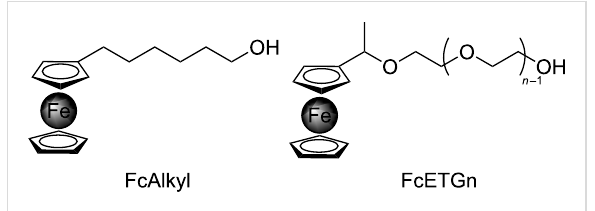
Figure 4: Ferrocene derivatives (FcAlkyl and FcETG n ) with different Table 1: Atomic percentages and C 1s contributions deduced from XPS analyses of raw, oxidized and functionalized samples. sample atomic concentrations